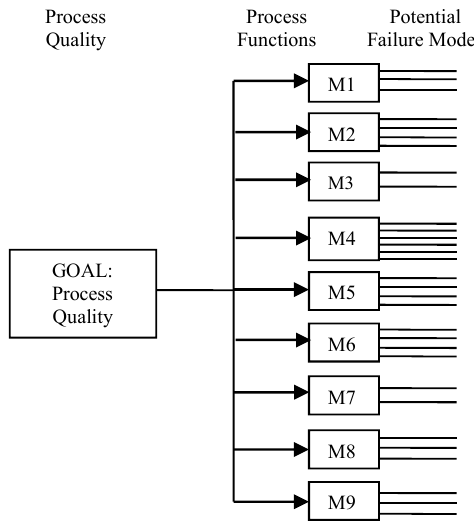
Fig. 2. Manufacturing process quality hierarchy